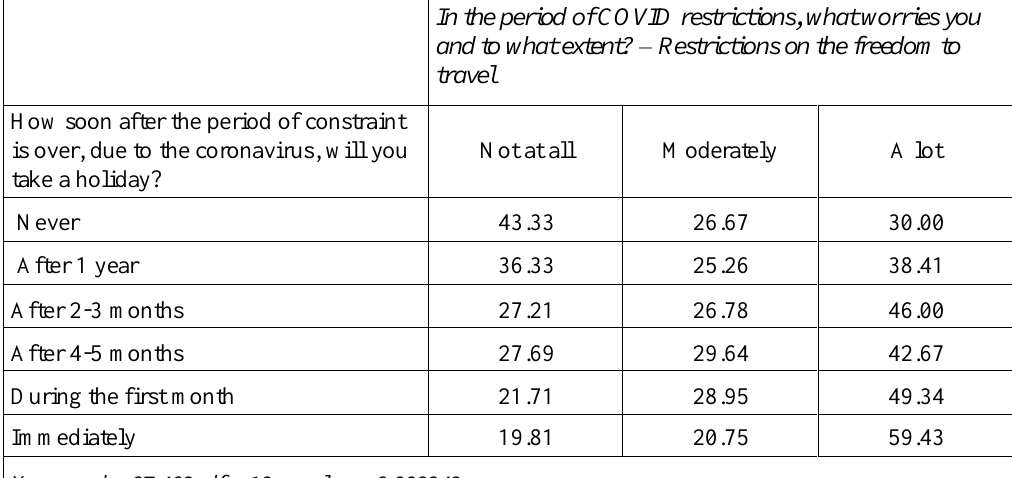
Table 3: Two-Way Table: In the Period of Covid Restrictions, What Worries You and to What Extent? – Restrictions on the Freedom to Travel In the period of COVID restrictions, what worries you and to what extent? – Restrictions on the freedom to